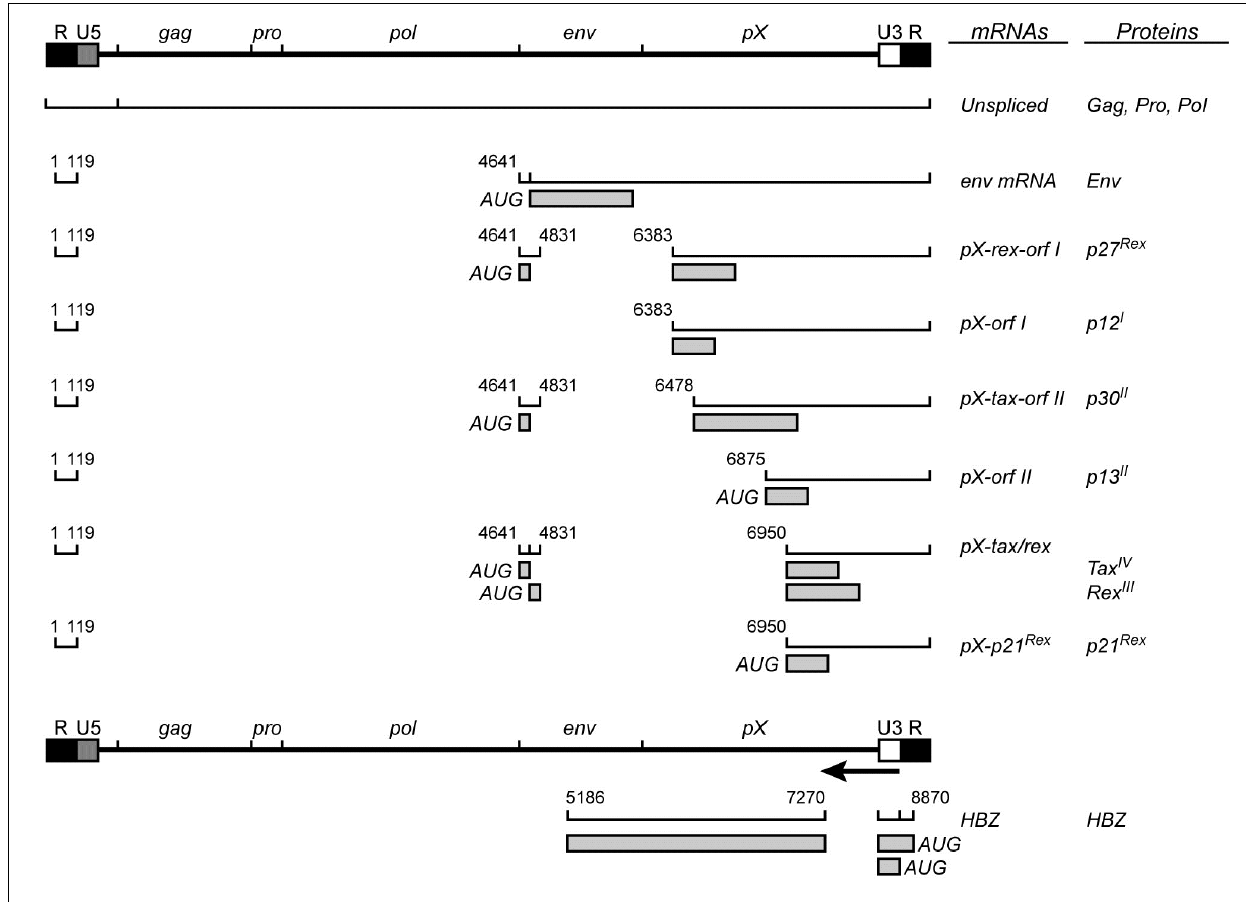
FIGURE 1 | HumanT cell leukemia virus type 1 genome with viral transcripts and encoded